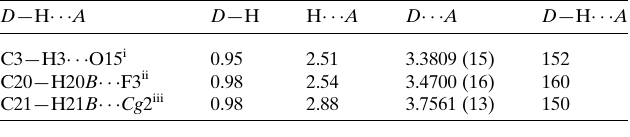
Table 1 Hydrogen-bond geometry (A˚ , (cid:2) ). Cg 2 is the centroid of the O19/C9–C12